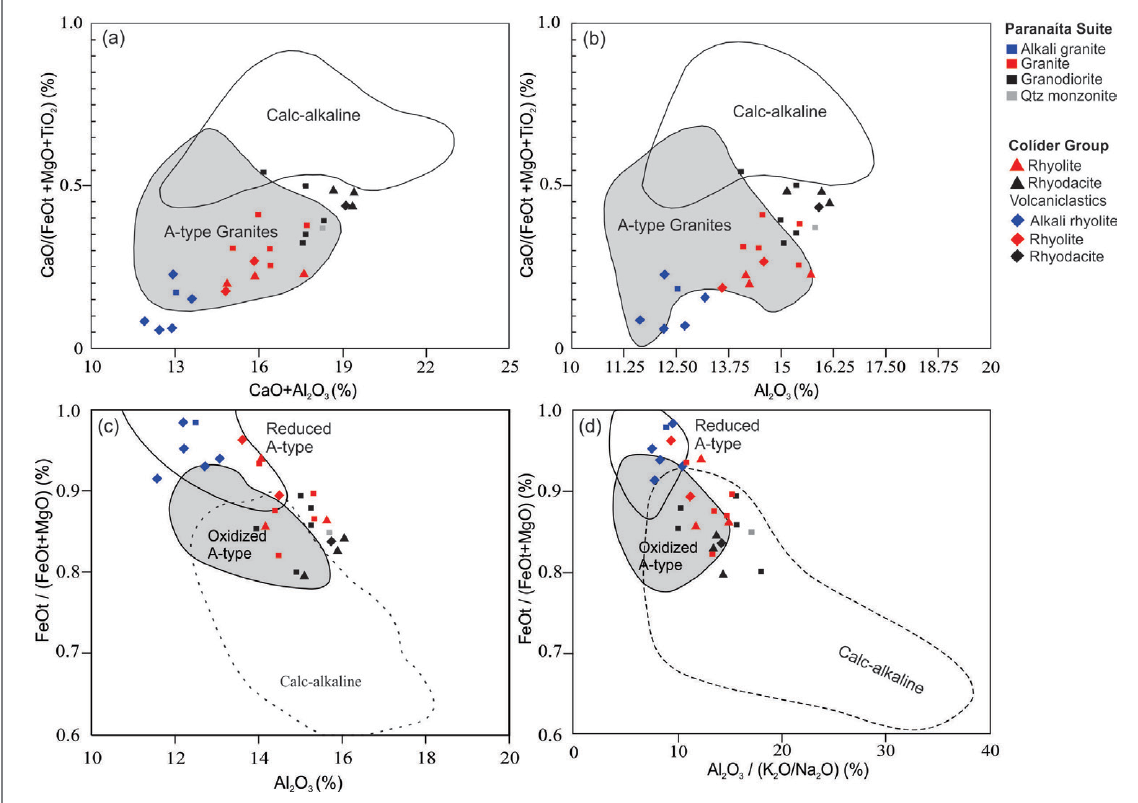
FIGURE 8 - Granite classification diagrams using major element concentrations for the acid rocks from the Volcanic Domain Dall`Agnol and Oliveira (2007). In (a) and (b) diagrams with the compositional fields of A-type and calc-alkaline granites. In (c) and (d) diagrams with the compositional fields of A-type reduced, oxidized and calc-alkaline